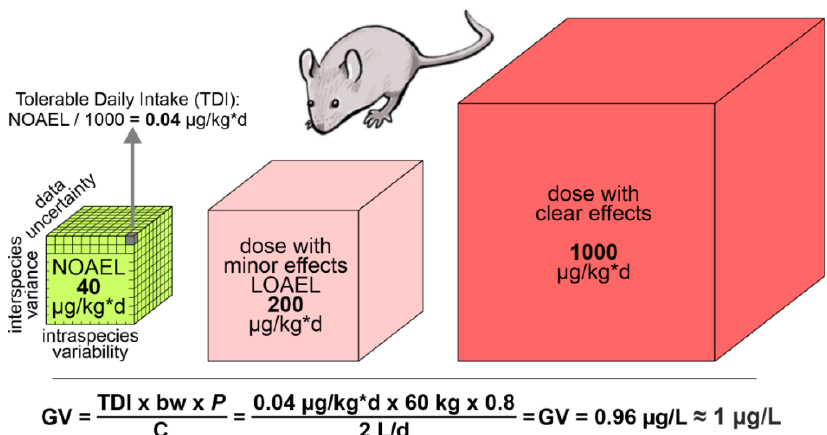
Figure 3. Schematic illustration of the derivation of tolerable daily intakes (TDI) and guideline values (GV) for lifetime daily exposure to 2 L of drinking water. The values for LOAEL and NOAEL are from the 13-week mouse study for Microcystin-LR by Fawell et al. [236]. The leftmost cube illustrates the derivation of TDI from NOAEL by applying uncertainty factors for interspecies variability (×10), intraspecies variance (×10), and data uncertainty for less than lifetime exposure (×10). From TDI the GV is derived by assuming a bodyweight of 60 kg, a proportion of uptake via drinking water of P = 0.8, and a daily water consumption of C = 2 L/day.